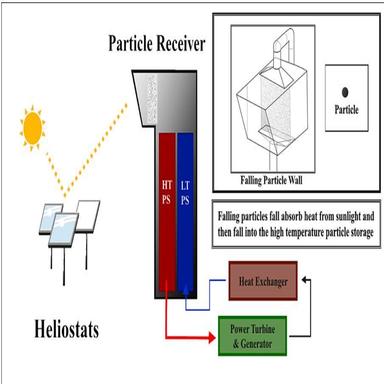
Conceptual diagram of CSP falling particle technology.